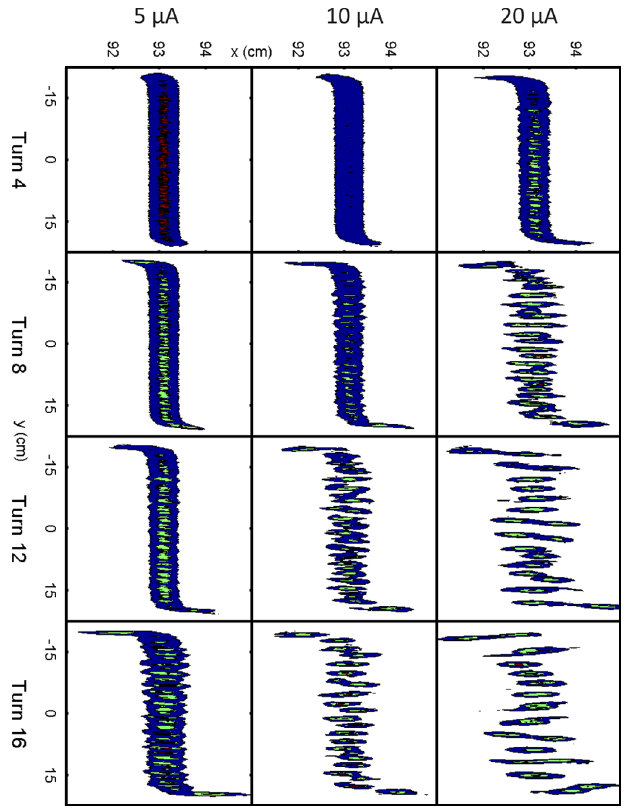
FIG. 6. (Color) Results of simulations of the beam dynamics in SIR for three different peak intensities: 5, 10, and 20 (cid:3) A . The bare machine optics is isochronous. Each frame contains a projection of the bunch charge density on the median plane for a given turn and intensity. The vector of velocity is directed from the top of the figure to the bottom. The horizontal axis of each frame corresponds to x measured in centimeters from the center of the ring. The vertical axis is along the beam trajectory. The size of each frame is 5 ð x Þ (cid:5) 45 ð z Þ cm 2